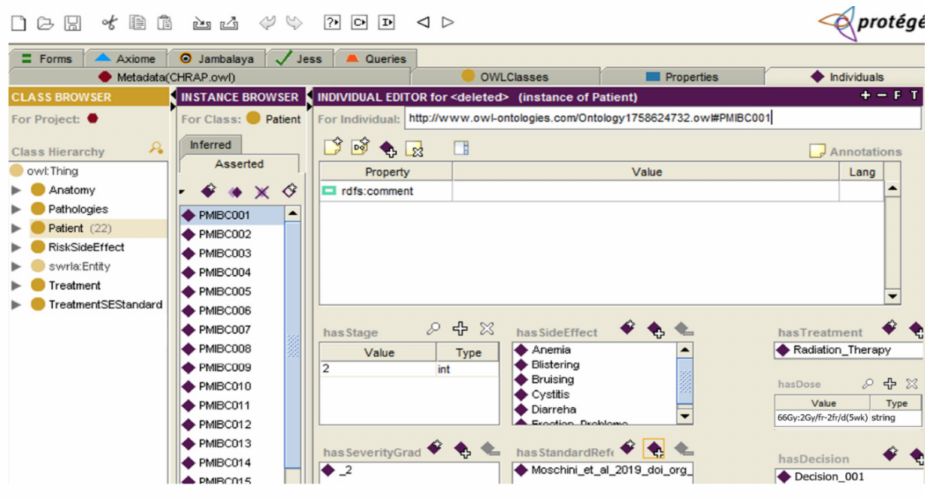
Figure 9. Jess query results generation and output reintegration into the ontology